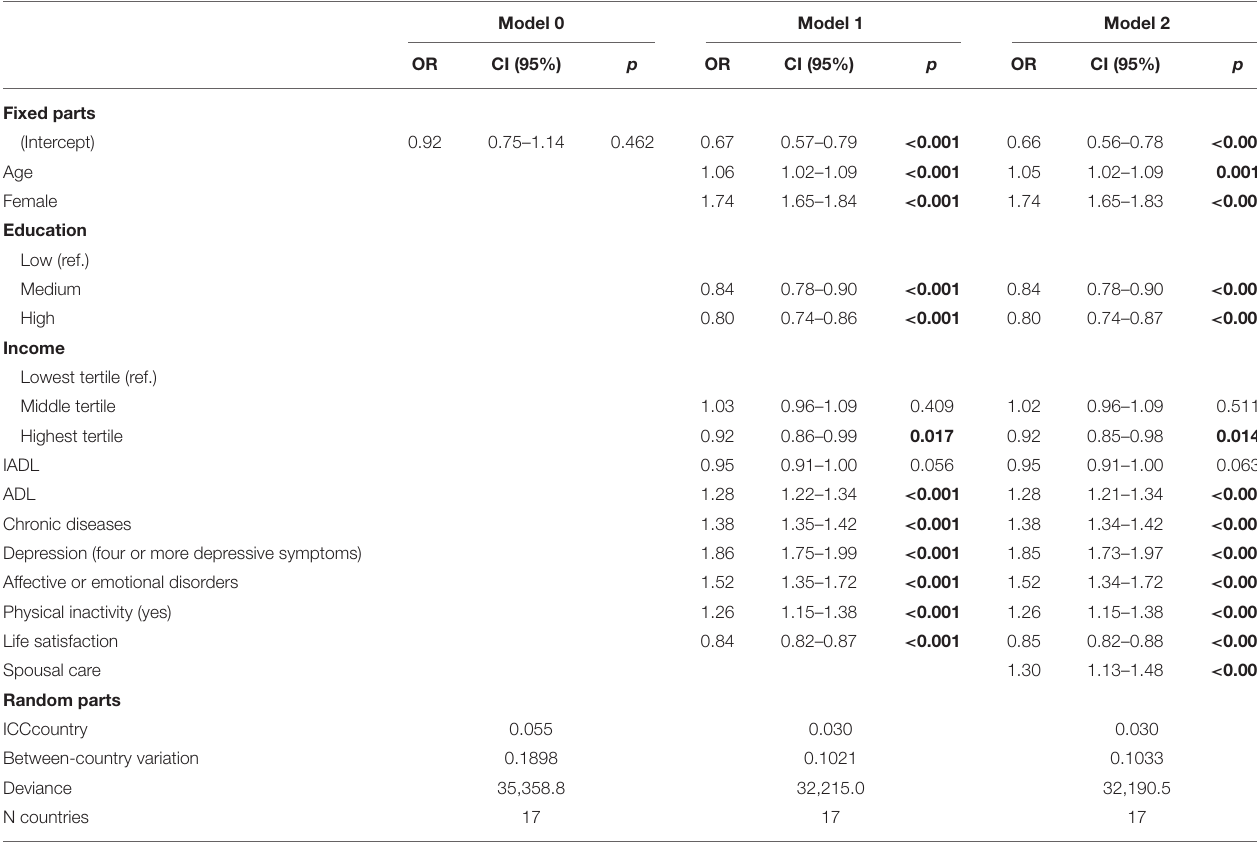
TABLE 2 | Multilevel logistic regression with troubled with pain as the